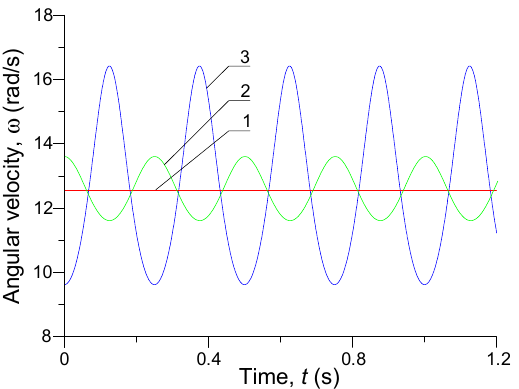
Figure 4. Angular velocity waveforms of three shafts: 1—first, 2—second, 3—third for the angles α 1,2 ≠ α 2,3 constant in time.